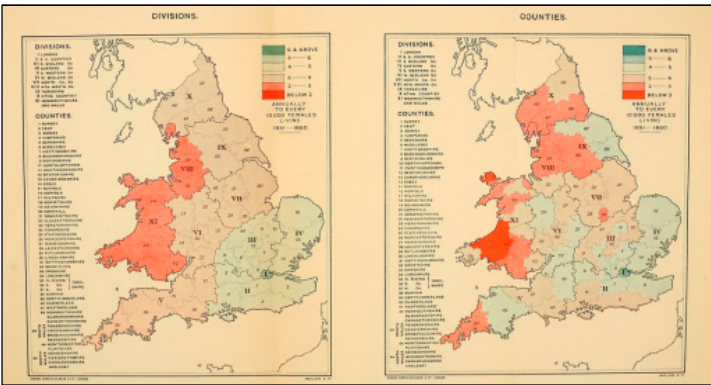
Figure 5. One of the atlas maps of geographical distribution of cancer disease in the Divisions and Counties of England and Wales, produced by Haviland, 1875 (Source: [13]).